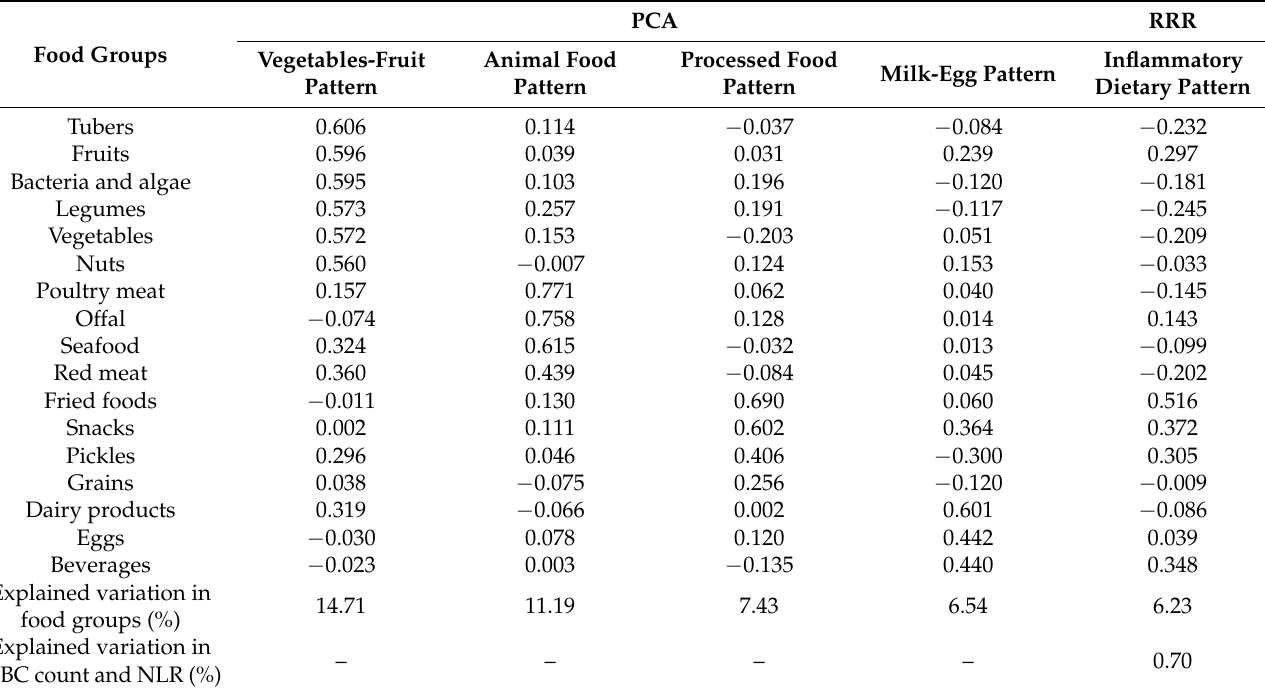
Table 3. Factor loadings of food groups for dietary